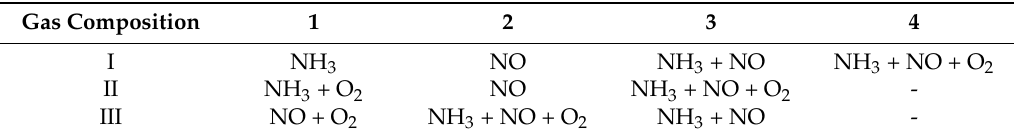
Table 1. The working conditions of transient SCR activity